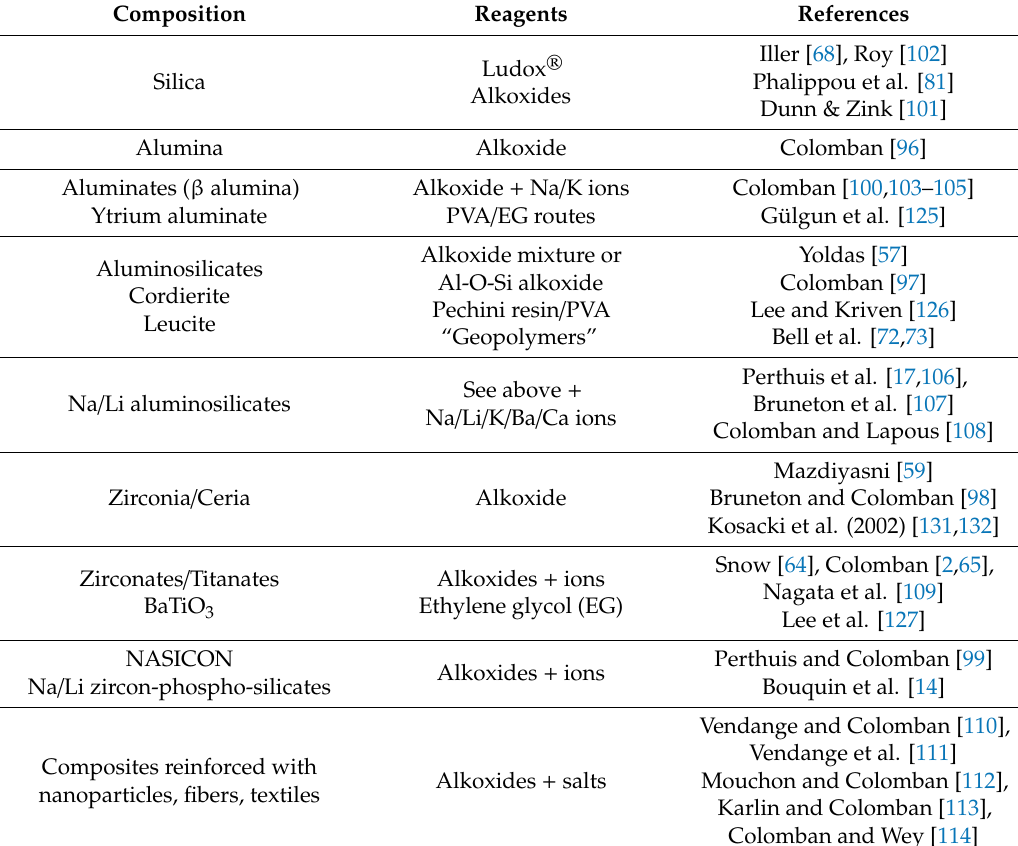
Examples of compositions prepared with liquid metal-organic